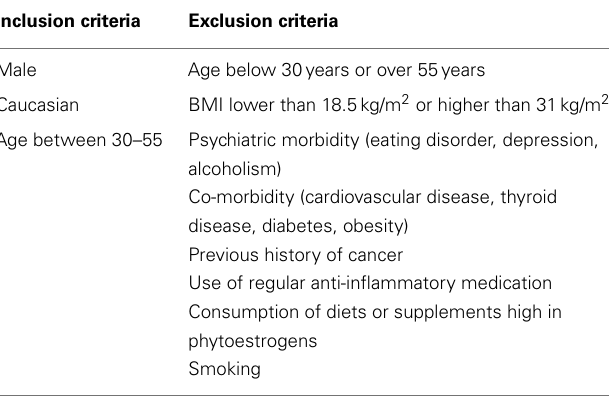
Table 1 | Subject recruiting criteria